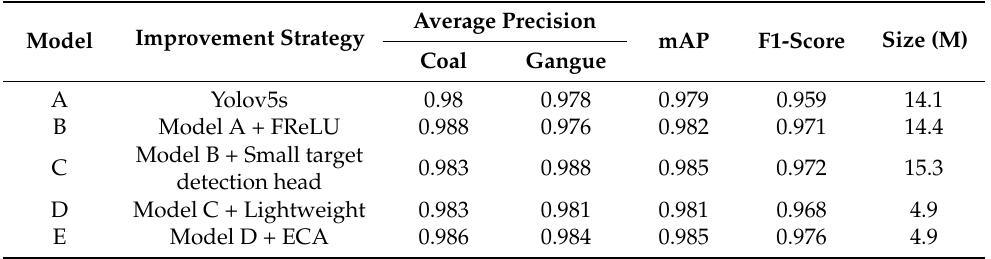
Table 6. Results of ablation experiments.